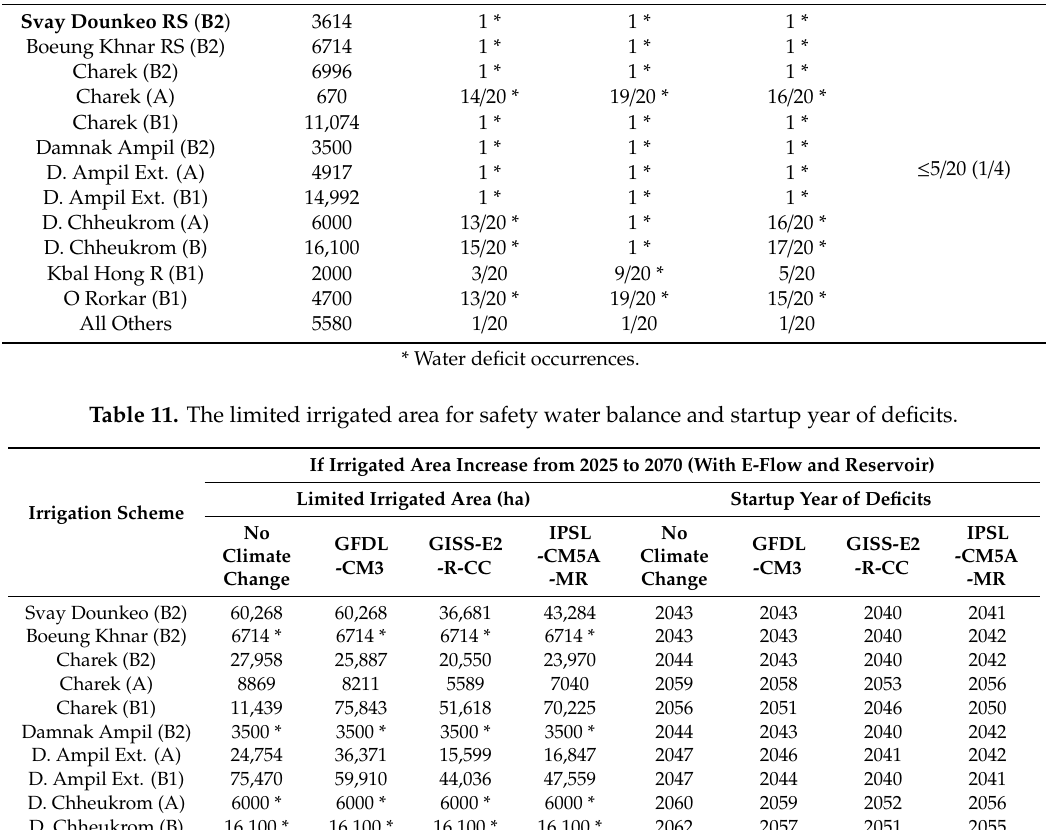
Table 10. The computation of water balance safety level in each irrigation scheme.